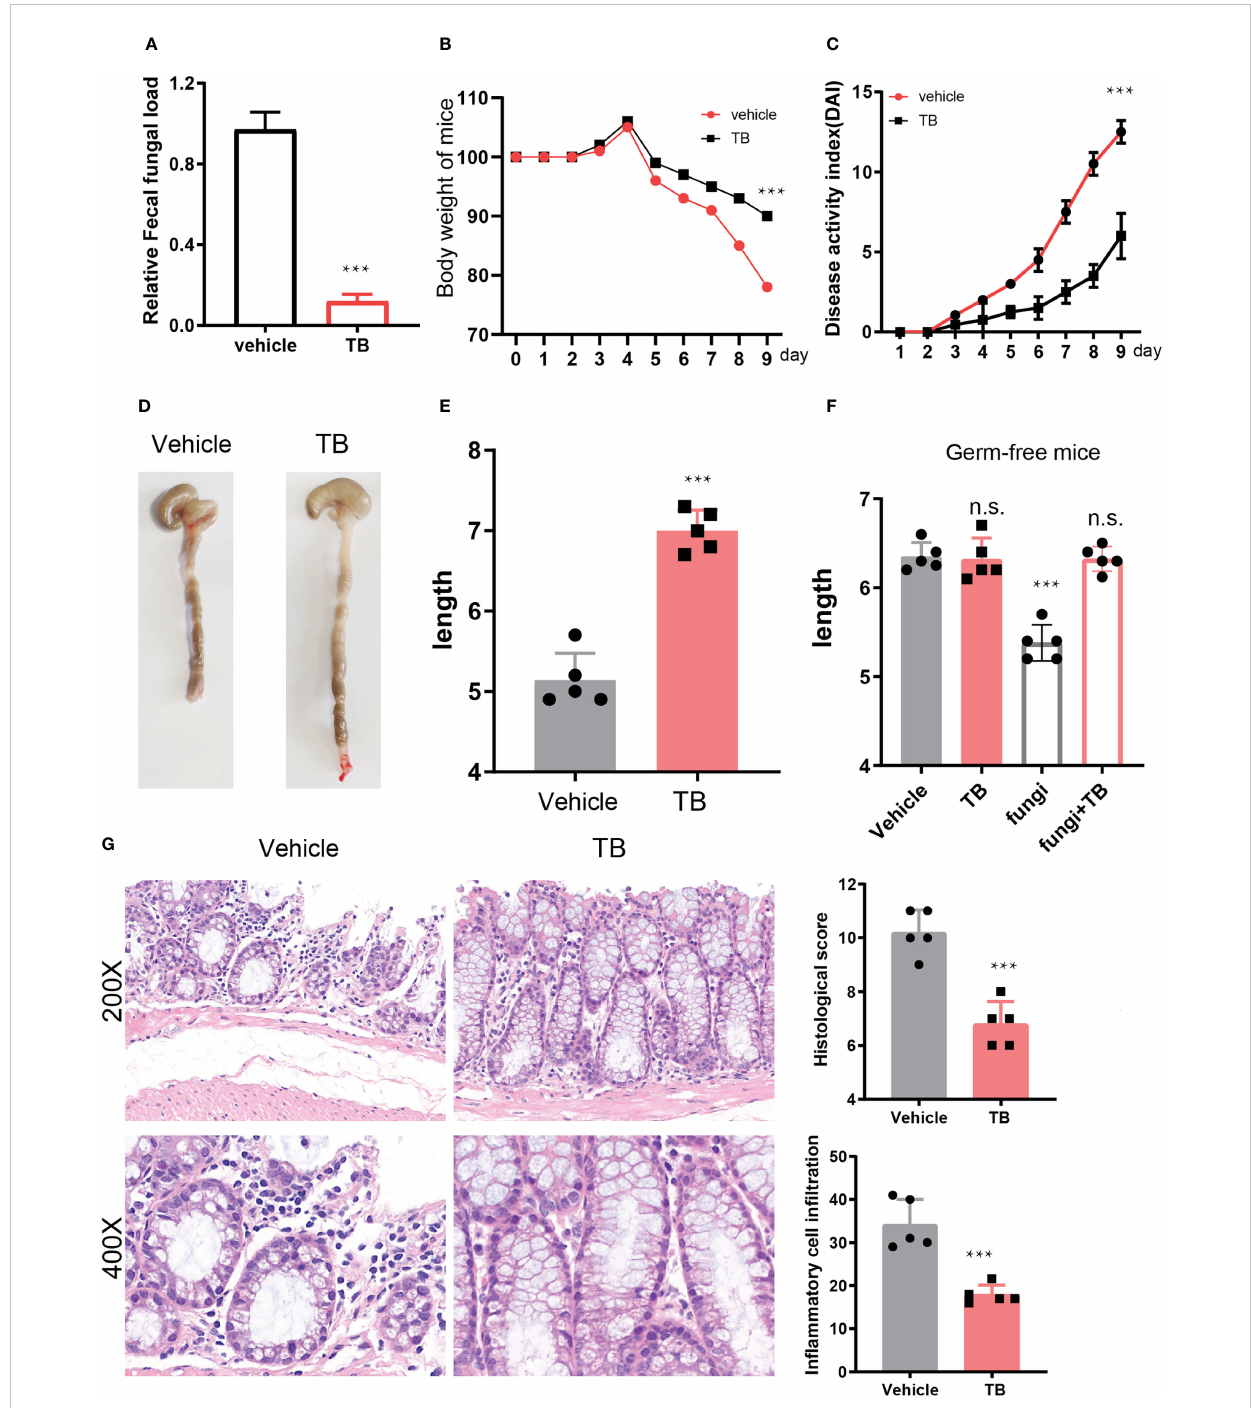
FIGURE 2 depletion fungi delayed the development of IBD. (A) . Fungal DNA in fecal samples from control and TB treated mice by detecting 18S RNA. (B) . The weight change curve of TNBS induced colitis under the treatment of terbina fi ne or not, n = 5. (C) . Disease activity index of mice IBD that treated with terbine fi ne or control counterpart, n = 5. (D) . Colon length of mice IBD with administration of terbina fi ne or not, n = 5. (E) . the statistical results of colon length in two group of mice, n = 5. (F) . the statistical results of colon length in germ-free mice that treated with TB, fungi or both TB and fungi. (G) . hematoxylin and eosin (H & E) staining of the colon sections from tebina fi ne treated or control group mice. ***P < 0.001 and n.s., no signi fi cance P >